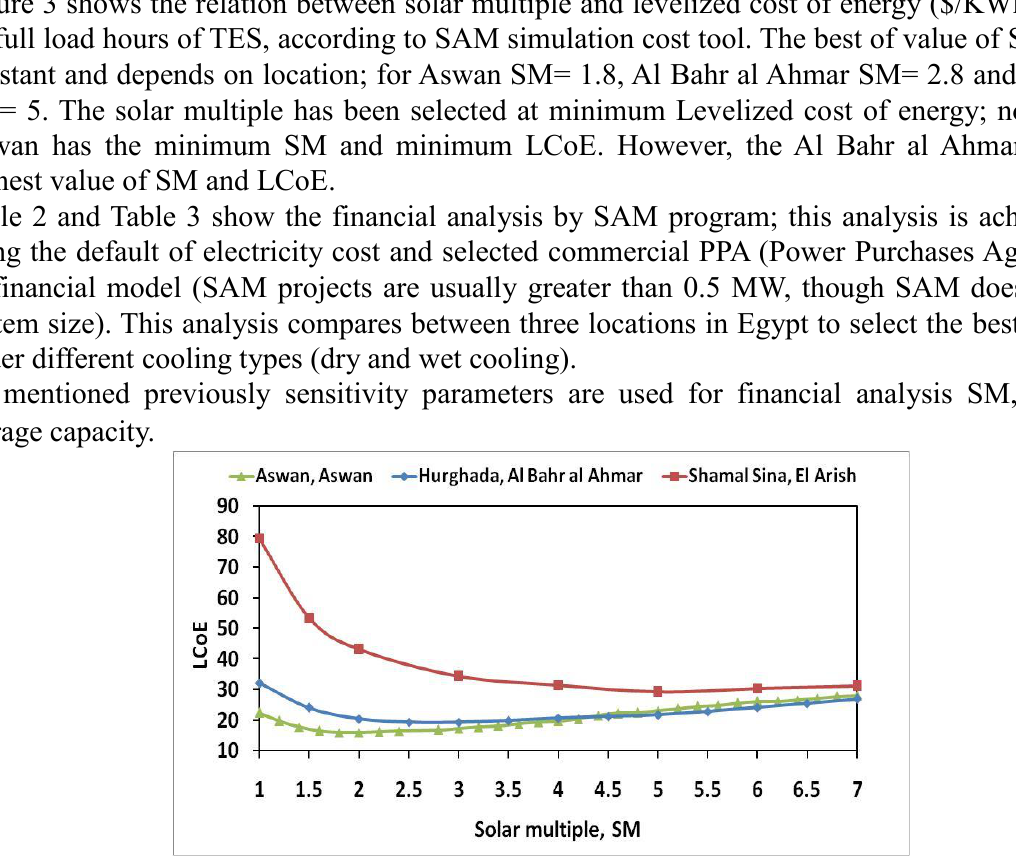
Fig. 3. Solar multiple Vs Levelized Cost of Energy. Cost analysis for dry